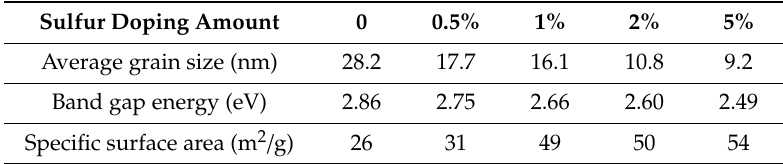
Table 1. The average crystallite size, band gap energy, and specific surface area of Bi 2 MoO 6 with different S doping amount.